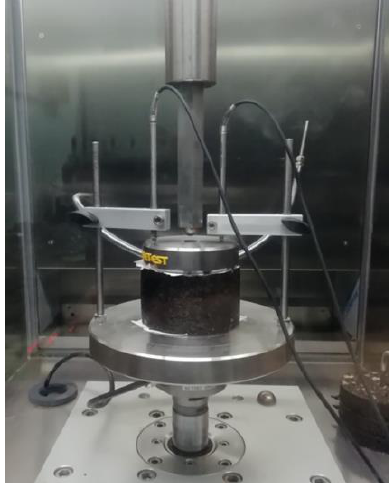
Figure 5. Dynamic creep test.